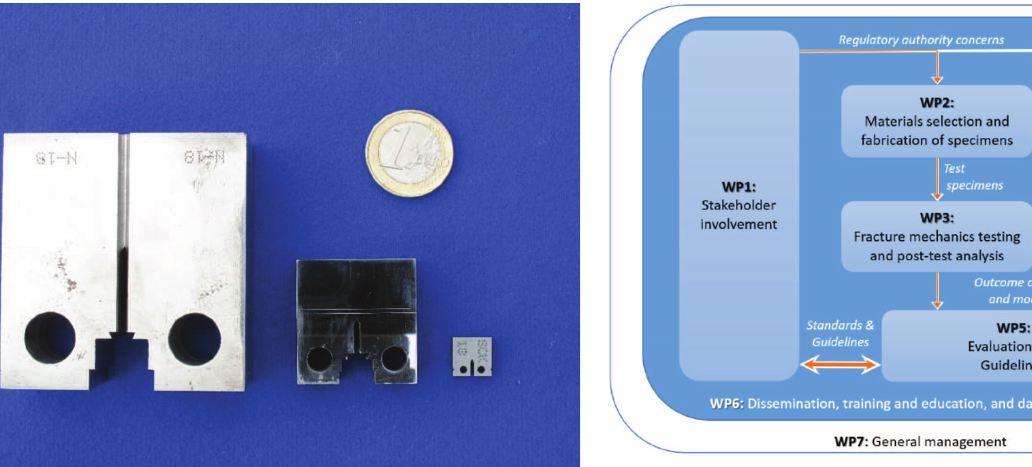
Fig. 6. Organisational structure of